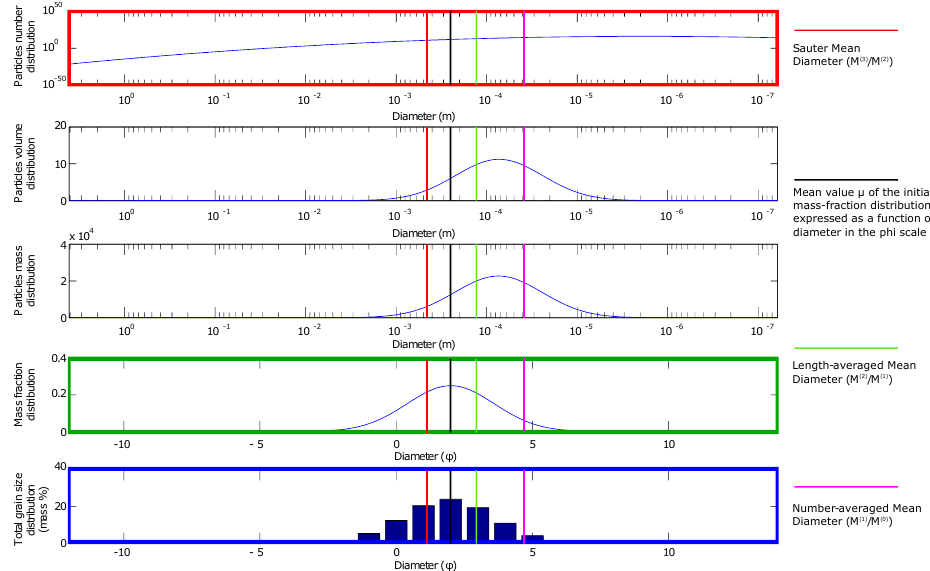
Figure 2. Visualization of a normal initial distribution in the Krumbein φ scale for the solid particles. On the top plot, the particle number distribution expressed as a function of the diameter expressed in meters is plotted. On the second and third plots from the top, the correspond- ing distributions of volume and mass are plotted, these two being different because the density is a function of the diameter. On the fourth plot the continuous distribution (lognormal) of mass fraction as a function of the φ scale is plotted, while in the last plot the distribution has been discretized with 13 bins in the range ( − 4;8). On each panel different average radii are also plotted, together with the mean of the initial distribution. The first, fourth and fifth panel are highlighted with different colors, also used in Fig. 4 for the solutions obtained with the three different representations of the initial grain-size distribution.